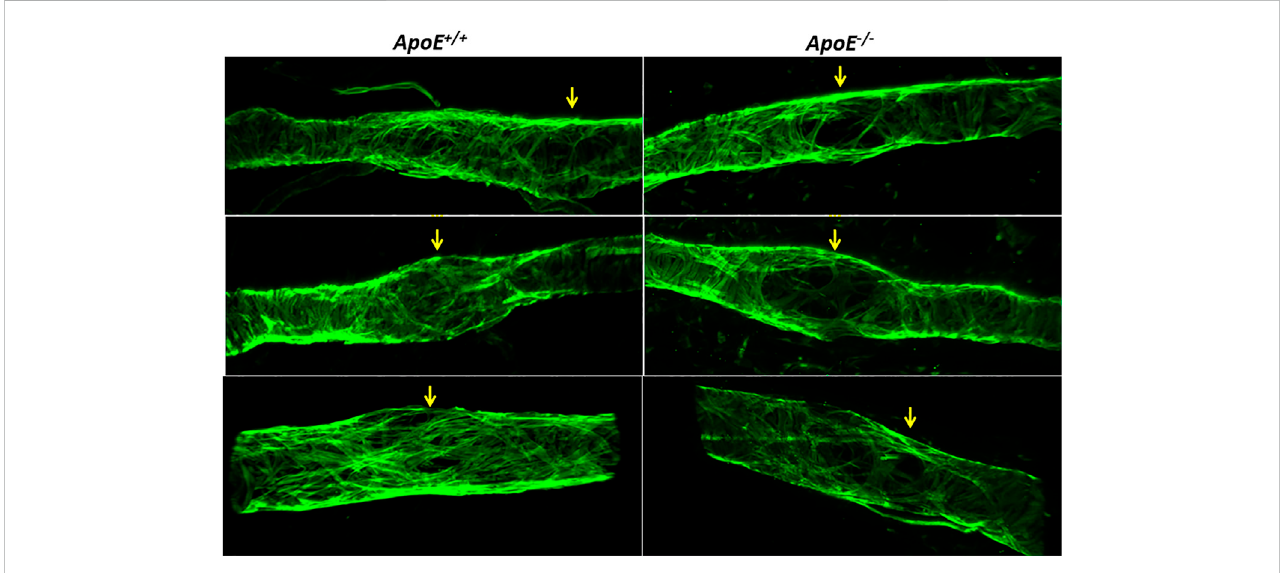
FIGURE 6 Low Investiture of lymphatic muscle cells at valve areas. Three examples showing that, compared to ApoE +/+ vessels, ApoE − / − vessels have reduced LMC coverage in valve sinus regions. LMCs were stained with anti-SMA. Valve regions were identi fi ed by CD31 staining (not shown for